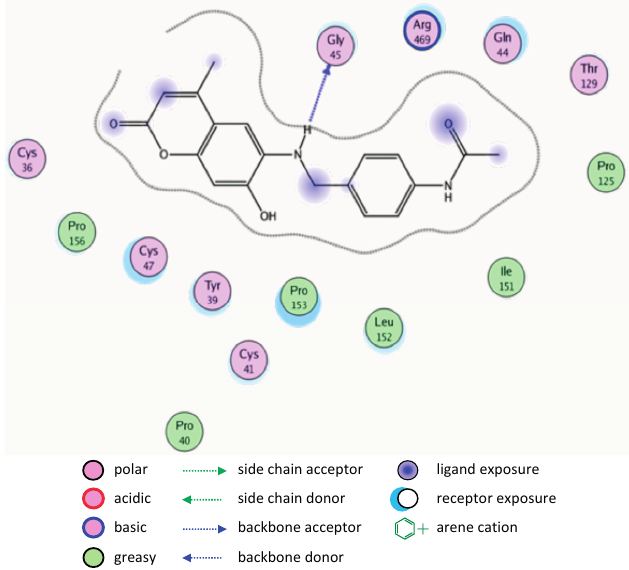
Figure 9. 2D representation of docking of compound 4 into the COX-1 active